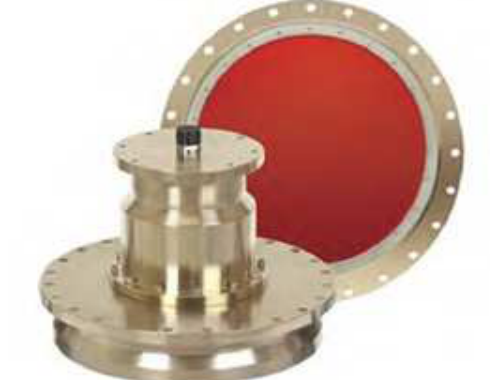
Figure 5. The Doppler current profiler